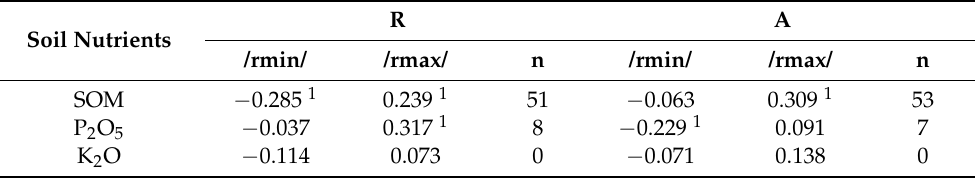
Figure 4. Correlation coefficients (r) between two PRISMA spectral formats and the soil nutrient contents. ( a ) reflectance (R), and ( b ) absorbance (A). Table 4. Correlations (r) between two PRISMA spectral formats (reflectance (R) and absorbance (A)) and soil nutrient contents.